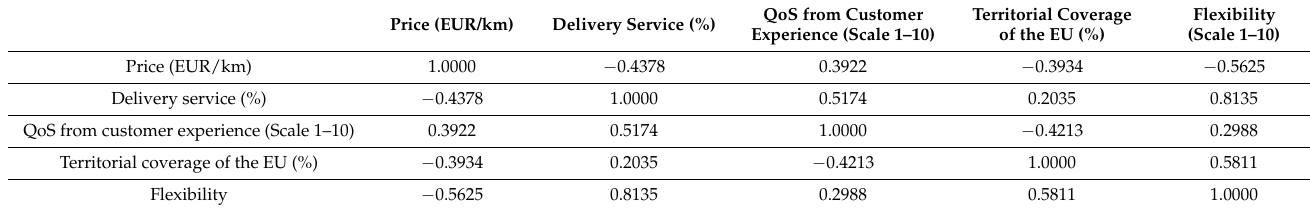
Table 8. m × m matrix (Source: Authors).